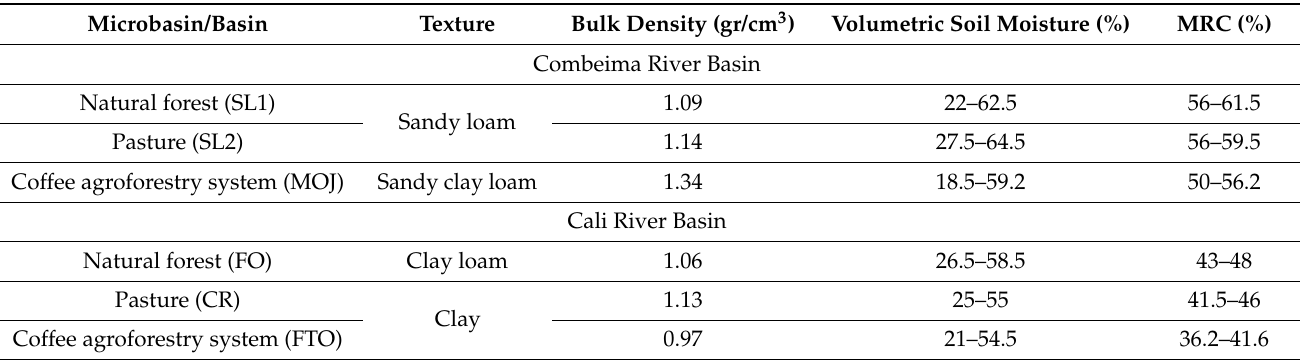
Table 3. Soil physical properties.